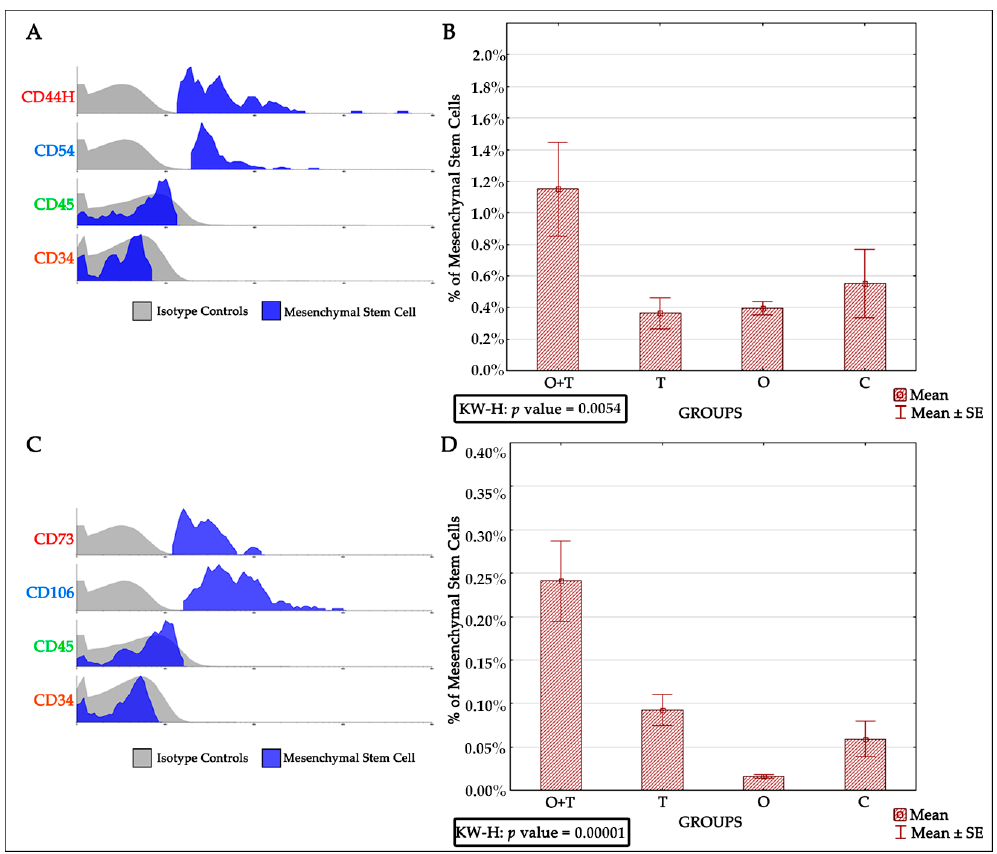
Figure 5. ( A ) Histogram of Mesenchymal Stem Cells (MSCs) characterized by CD44H++, CD54+++, CD45 − , and CD34 − ; ( B ) Graph of the percentages of MSC number and the result of the Kruskal-Wallis statistical test, p value = 0.0054; ( C ) Histogram of the mesenchymal stem cells characterized by the presence of CD73+, CD106+, CD45 − , and CD34 − ; ( D ) Graph of the percentages of MSC number and the result of the Kruskal-Wallis statistical test, p value = 0.00001.